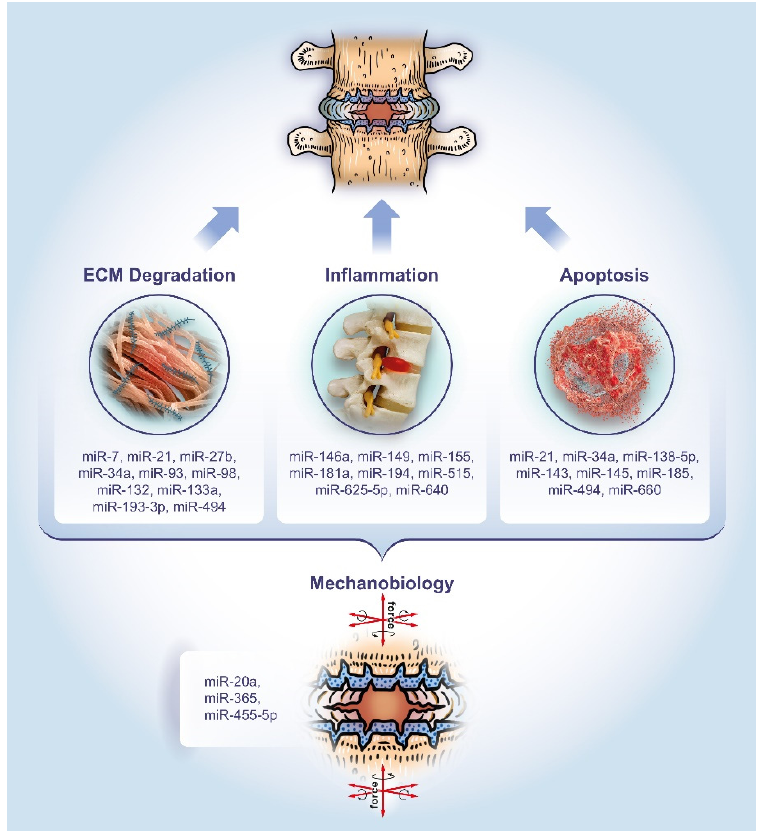
Figure 1. The role of microRNAs in the pathology of DDD. The miRNAs listed have been studied for their involvement in extracellular matrix (ECM) degradation, apoptosis, and inflammation, as well as mechanobiology as an overarching theme, respectively.